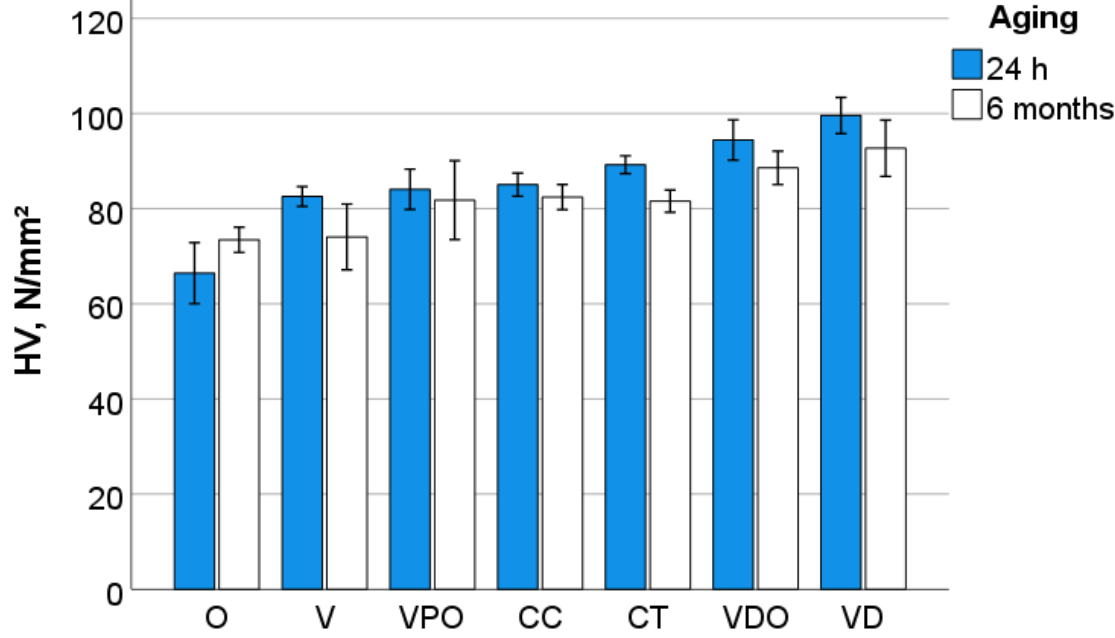
Figure 6. Variation of the Vickers hardness (HV) as a function of RBC and aging conditions (mean values with 95% confidence interval).